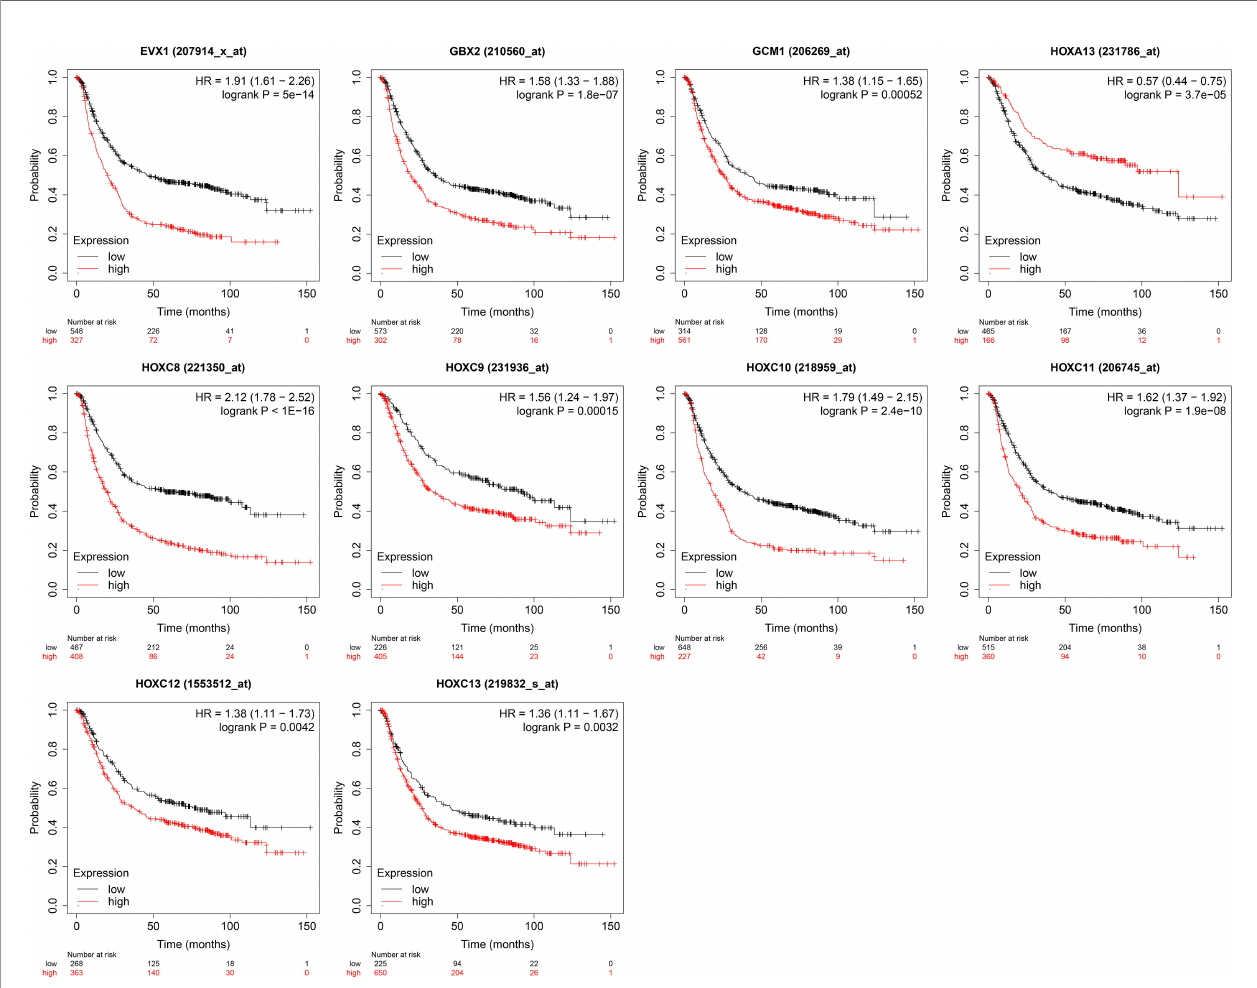
FIGURE 7 | Kaplan survival analysis for the association of gene expression levels and the overall survival of patients with gastric cancer. The genes including EXV1, GBX2, GCM1, HOXA13, HOXC8, HOXC9, HOXC10, HOXC11, HOXC12 and HOXC13 were chosen for the survival